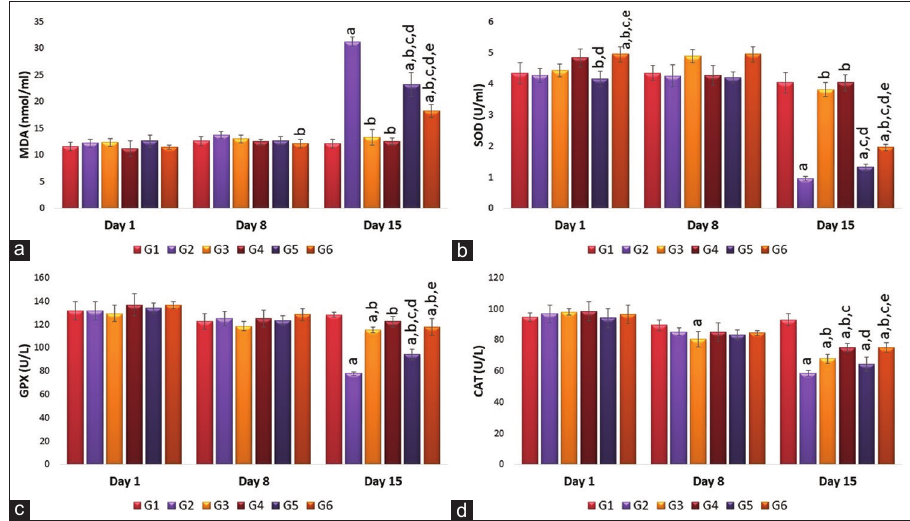
Figure-8: (a-d) Effects of single and repeated intravenous injection of 300 μ g/kg body weight 50 nm either gold nanosphere or gold nanorods in male rabbits on malondialdehyde, superoxide dismutase, glutathione peroxidase, and catalase on days 1, 8, and 15 post-treatment. Means carrying superscripts are significantly different at p<0.05 based on Tukey’s honestly significant difference. a=Significantly different versus G1, b=Significantly different versus G2, c=Significantly different versus G3, d=Significantly different versus G4, and e=Significantly different versus